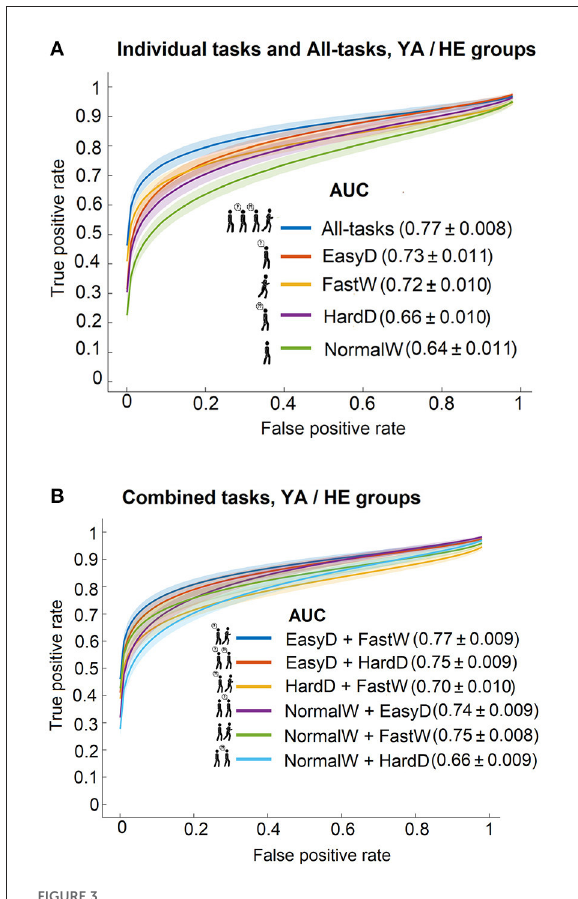
FIGURE3 ROC curves with 95% confidence bands and model AUC values for predicting the cognitive status between YA and HE groups using (A) the individual walking tasks and the all-tasks, and (B) the walking task pairs.